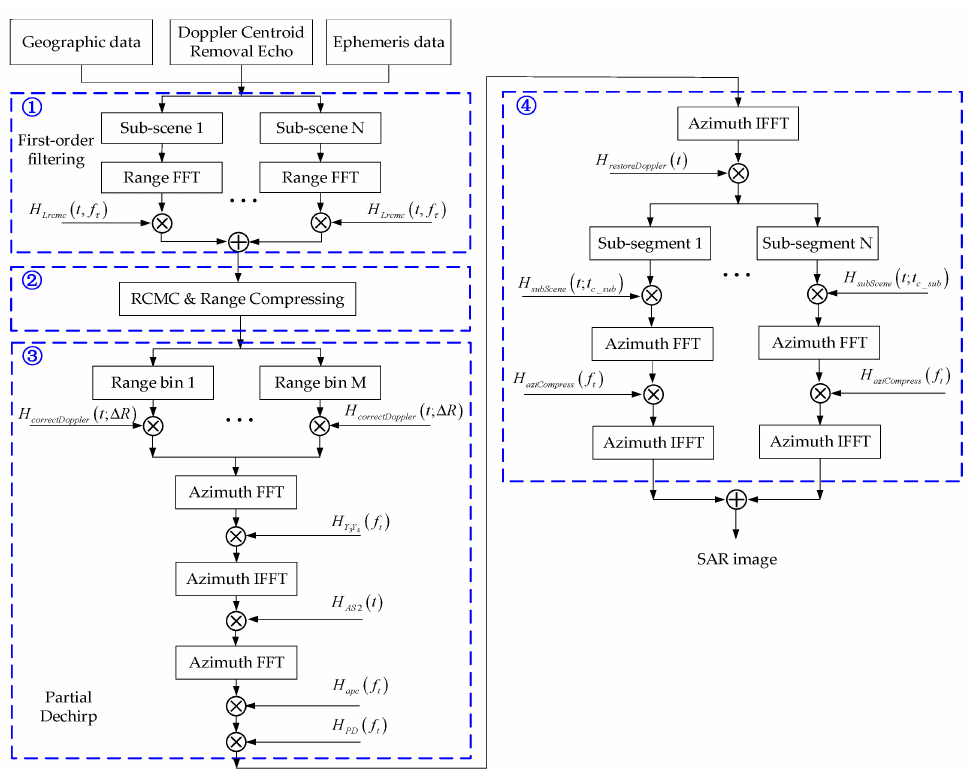
Figure 10. Flowchart for the proposed squint mode GEO SAR imaging algorithm, which is composed of four steps. Step 1 is first-order filtering. Step 2 includes range cell migration correction (RCMC) and range compression. Step 3 implements partial dechirp. Azimuth compensation is accomplished in Step